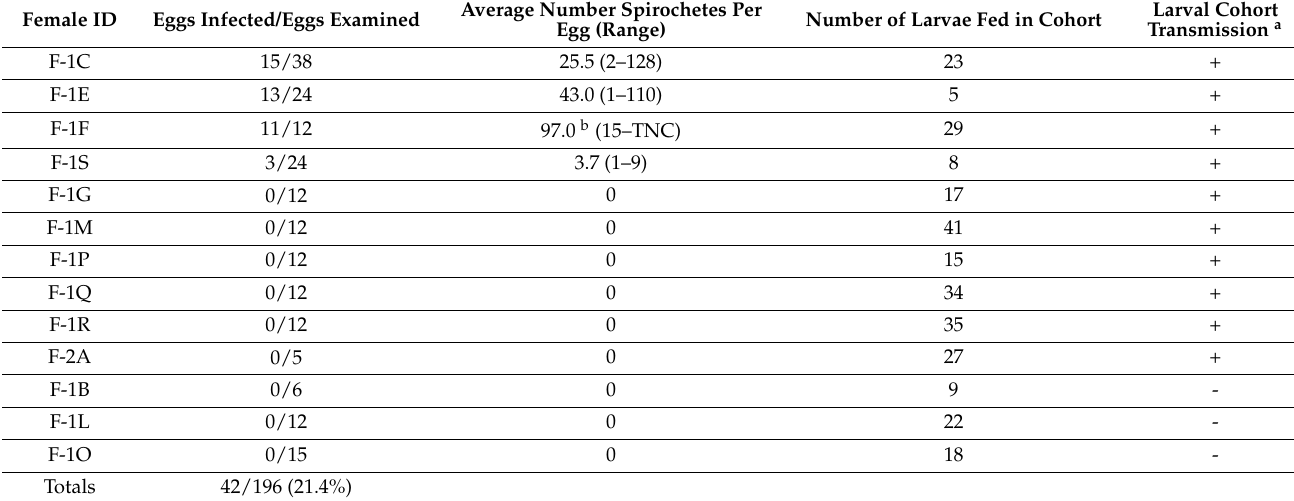
(Table 5). Table 5. Examination of eggs from infected Ornithodoros hermsi females by immunofluorescent microscopy and same-clutch larval feeding on mice.